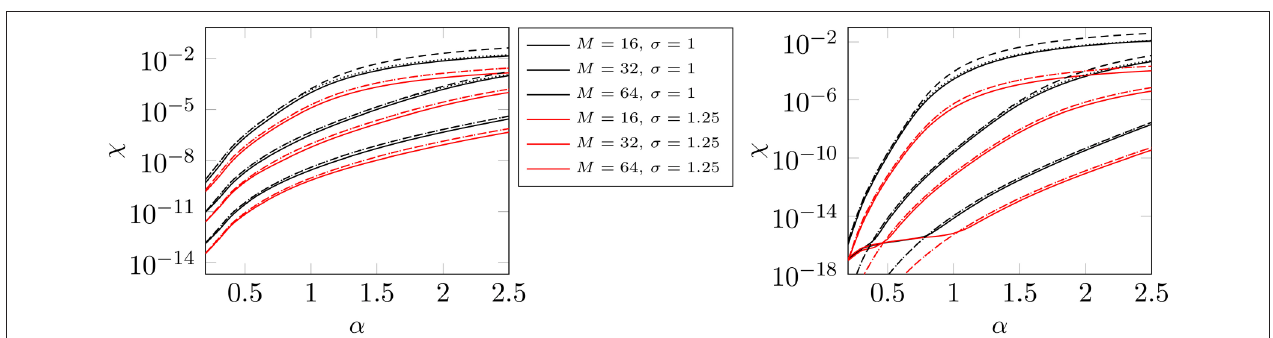
FIGURE 2 | Approximate values for χ opt via Equation (46) (dotted) and χ std via Equation (45) (dashed) for different far field cutoffs M with respect to the splitting parameter α . Thereby we choose the support parameter m corresponding measured errors χ std are represented by the solid lines. (Window function: B-spline).